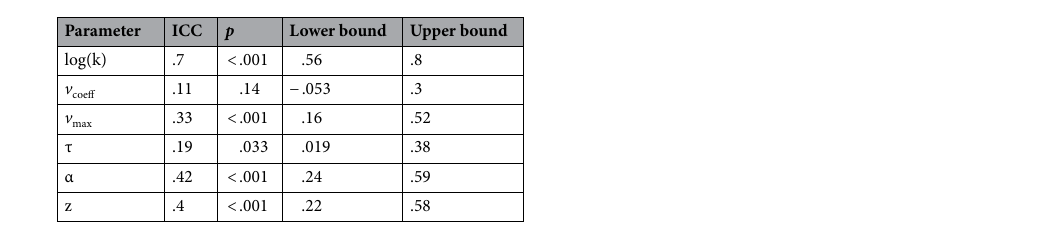
Table 6. Summary of the results of the ICC analysis of the DDM S parameters.